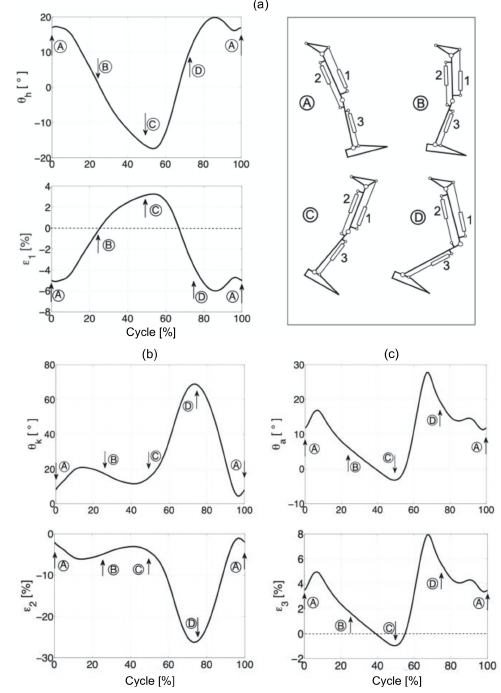
Figure 5. The angles in the joints and length of the hydraulic exoskeleton actuators, while walking: Hip joint ( a ), knee joint ( b ), and ankle joint ( c